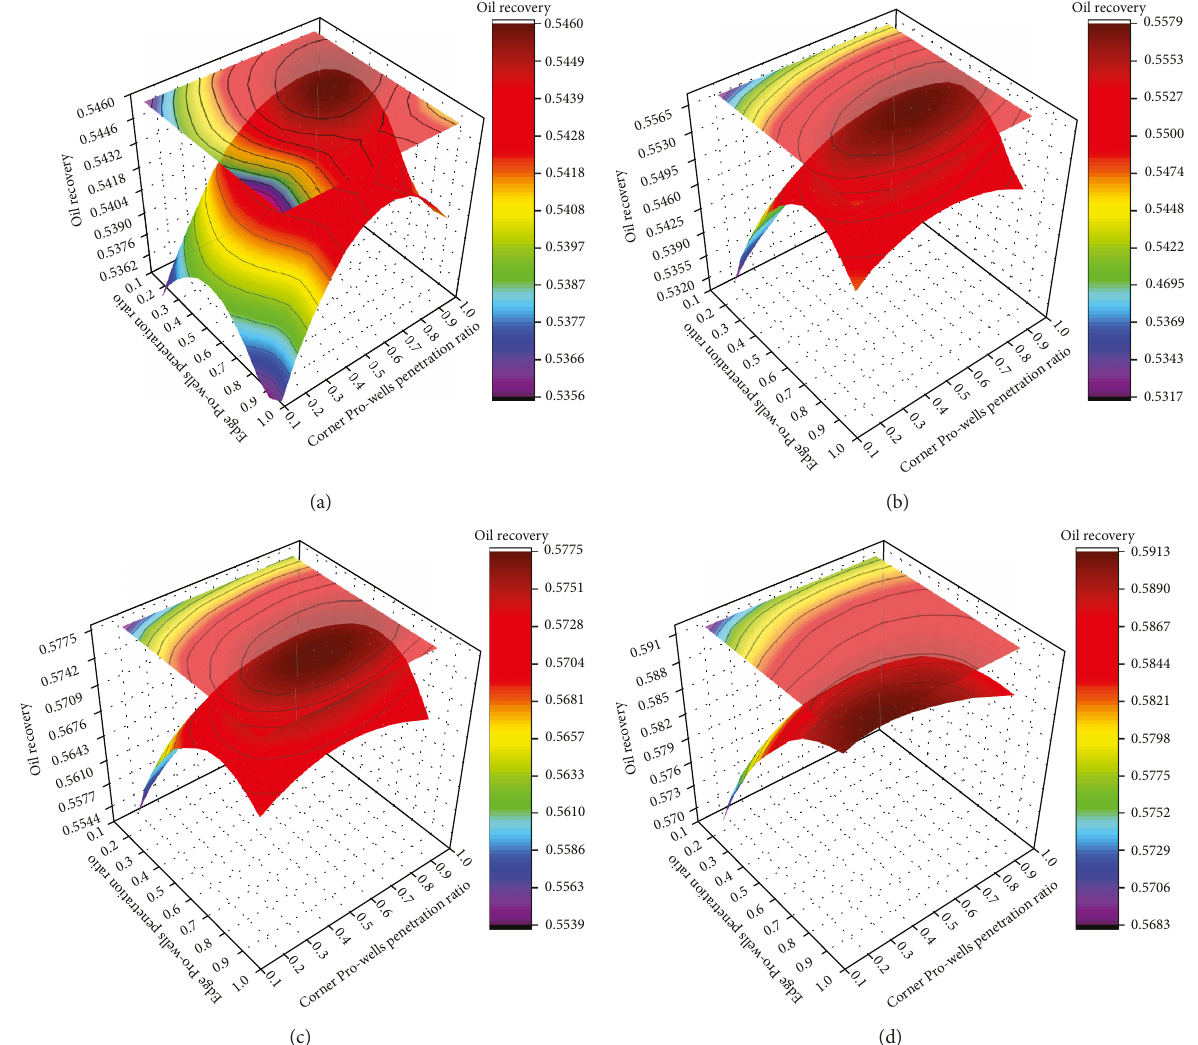
: k is 3 :1; (c) reservoir permeability k x y